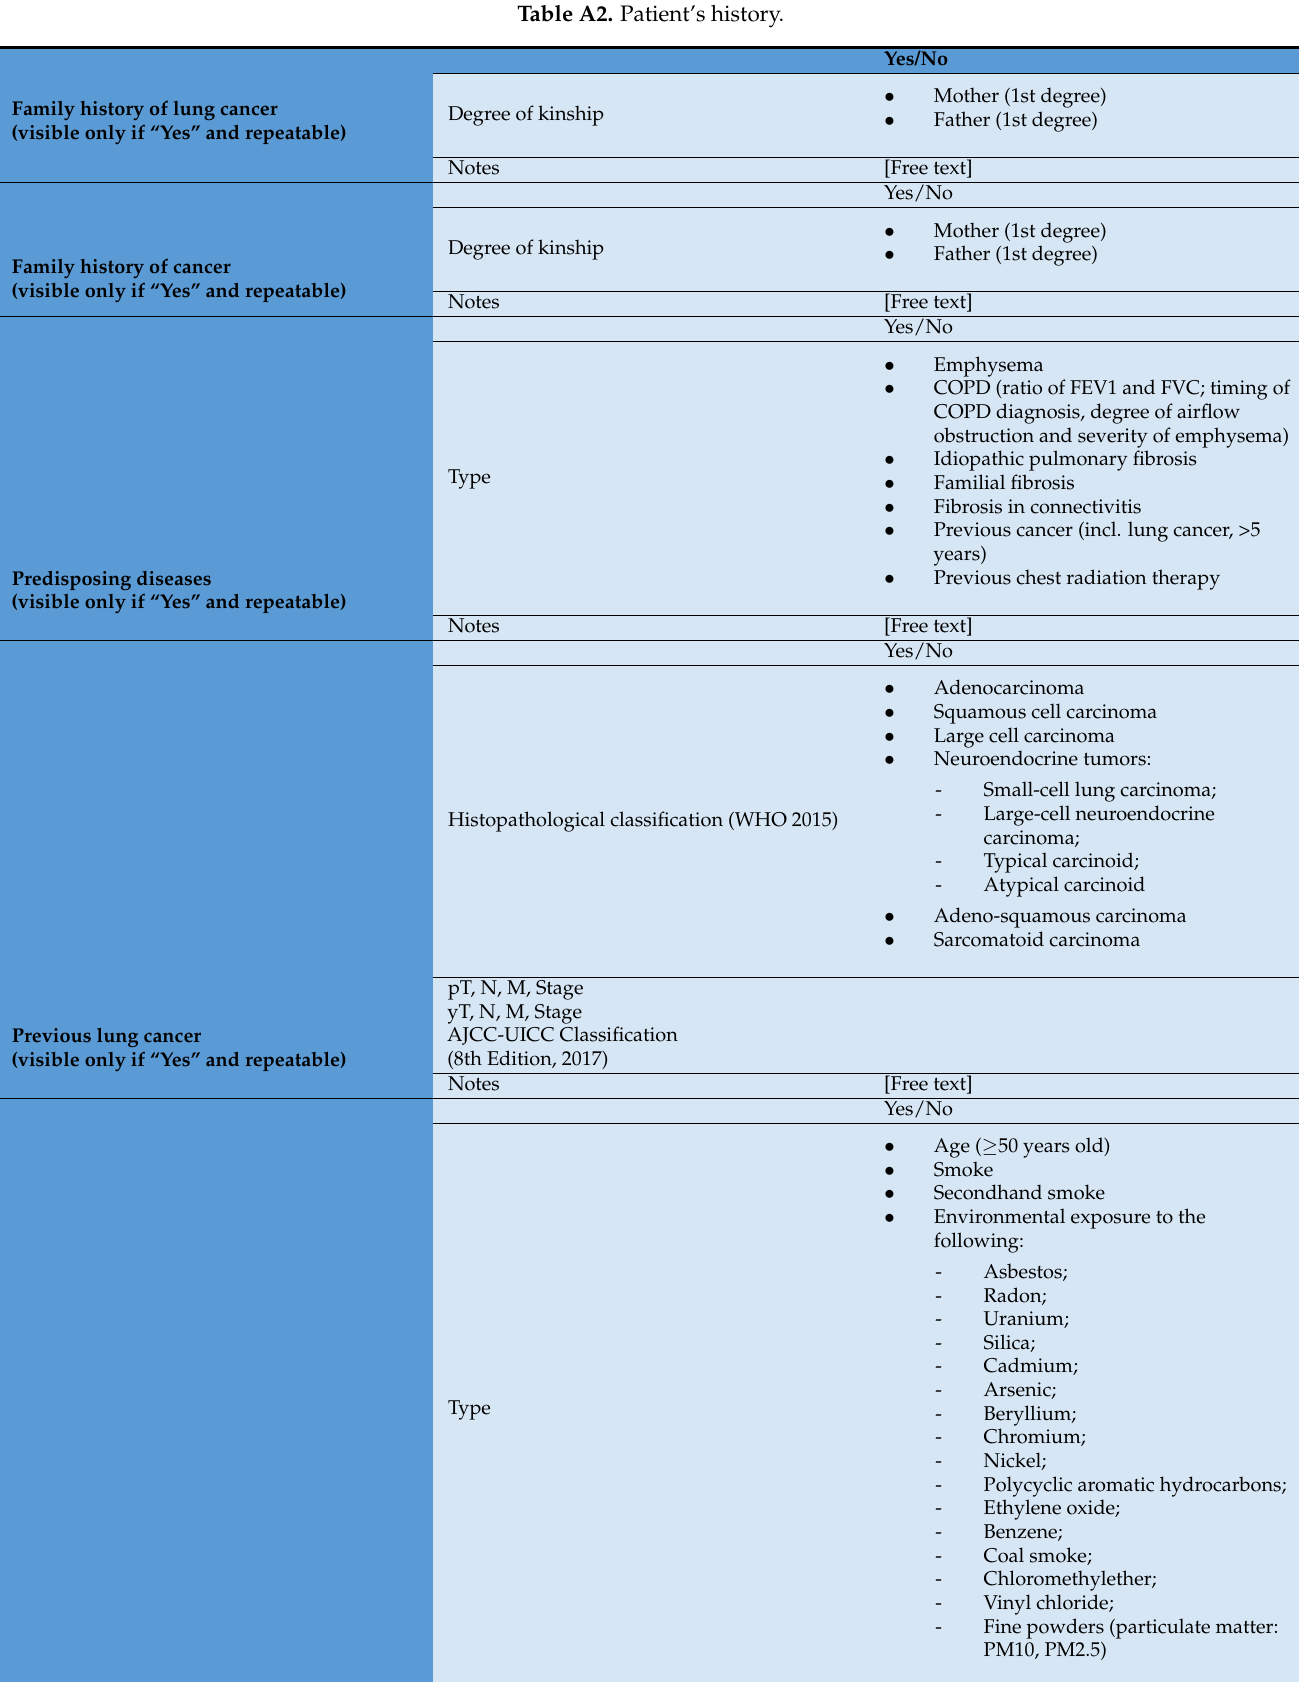
Table A2. Patient’s